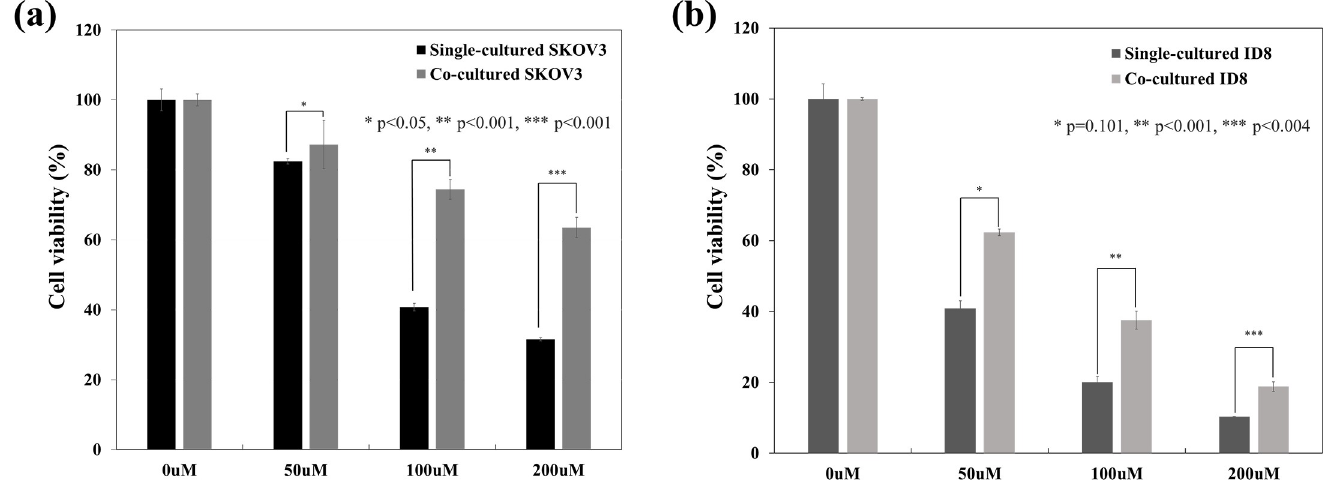
Fig 3. Viability of the single-cultured and co-cultured ovarian cancer cells following carboplatin treatment. (a) SKOV3 cells co-cultured with THP-1 cells. � p < 0.05, �� p < 0.001, ��� p < 0.001. (b) ID8 cells co-cultured with RAW264.7 cells. � p = 0.101, �� p < 0.001, ��� p < 0.004.